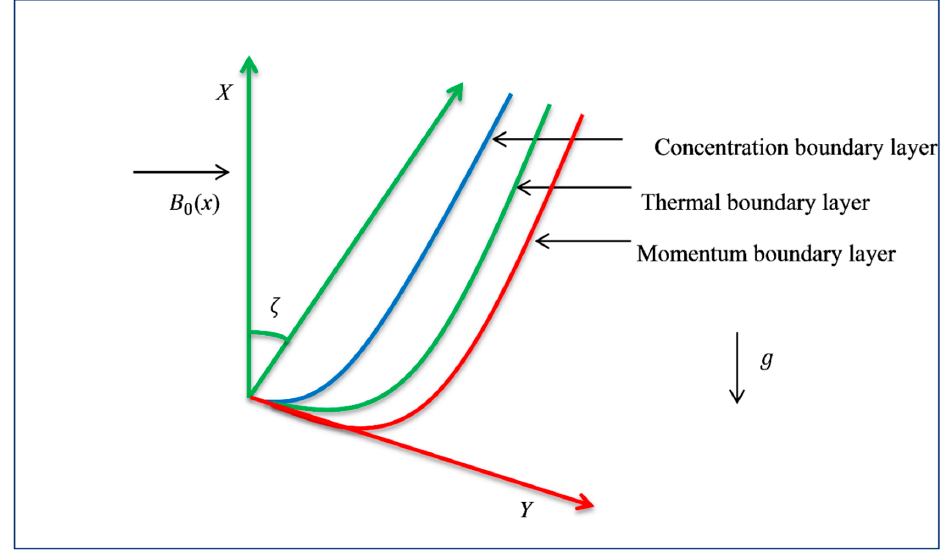
Figure 1. Physical geometry with coordinate system.